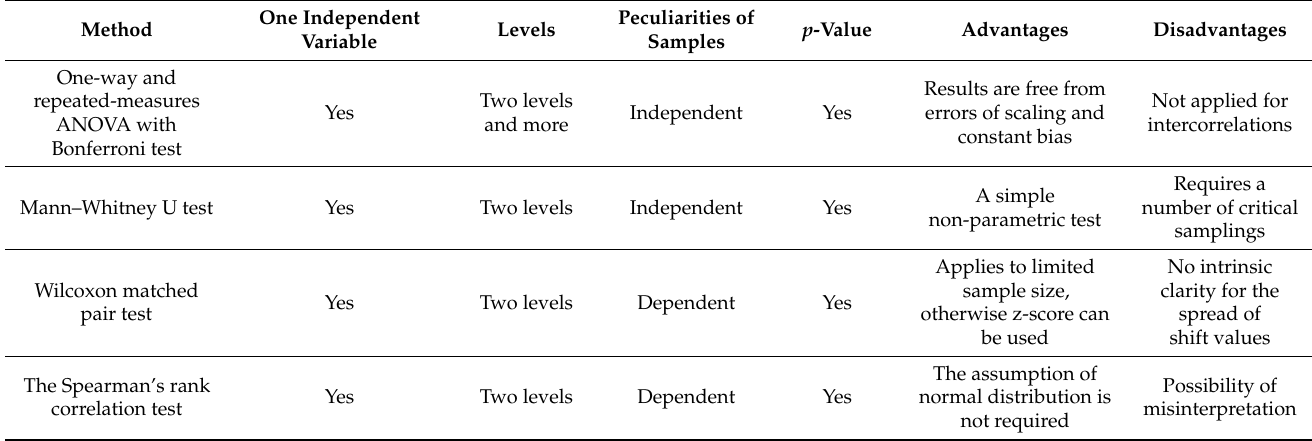
Table 5. Statistical analysis methods used for the data